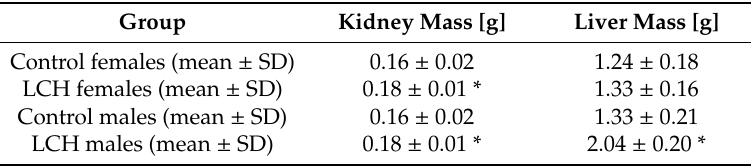
Table 2. Liver and kidney mass in the animals.